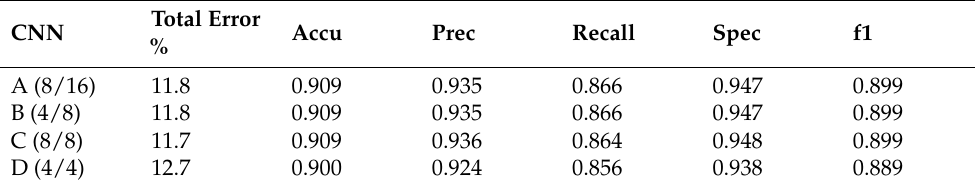
Table 3. Statistical measures of the different CNN model